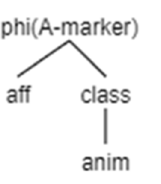
Figure 21. After insertion of v*, inheritance, Agree, and labeling.